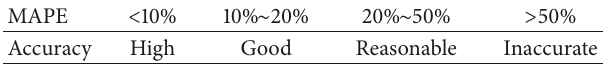
Table 1: Classification of model forecasting ability by